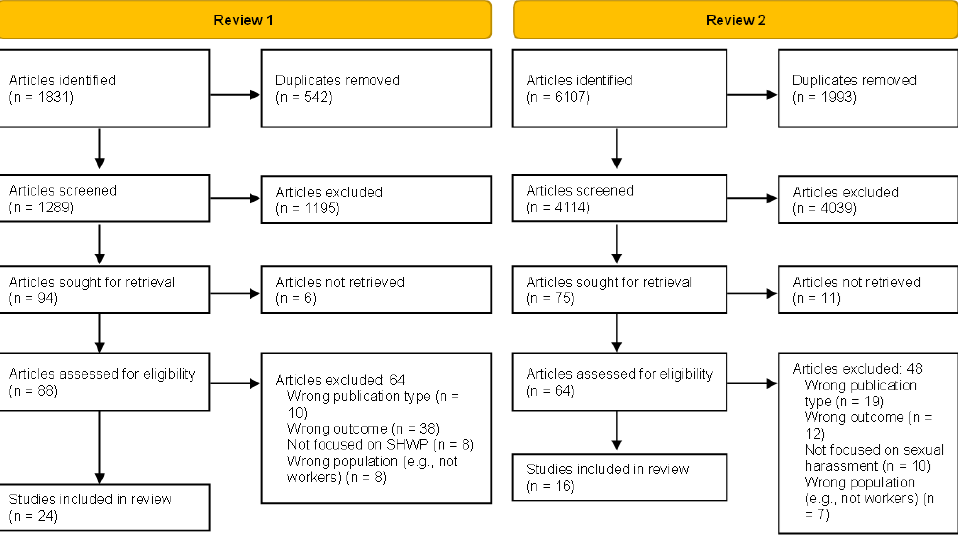
Figure 1. PRISMA